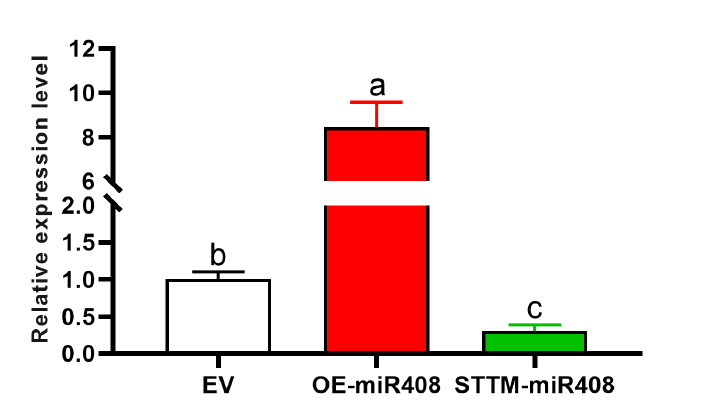
Figure 5. The expression level of miR408 in transgenic OE- miR408 and STTM- miR408 soybean hairy roots. The level of expression was normalized to the level of U6 . Each bar shows the mean ± SE of triplicate assays. Statistical comparisons between nematodes in EV and other transgenic hairy roots were made by one-way analysis of variance (ANOVA). Different characters mean significant differences found at p <